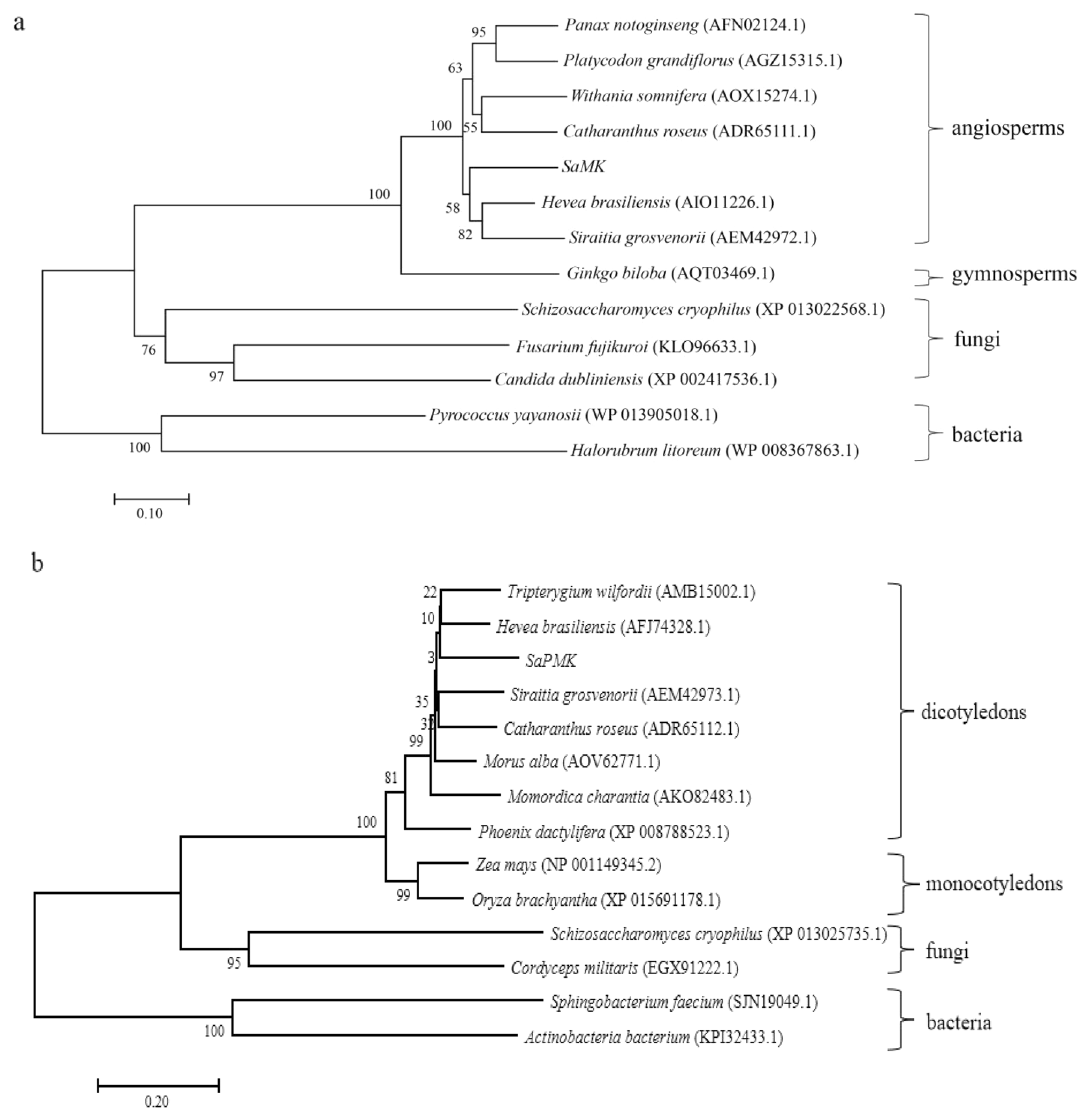
Figure 4. Phylogenetic trees of SaMK and SaPMK proteins in Santalum album relative to other organisms. ( a ) SaMK; ( b )